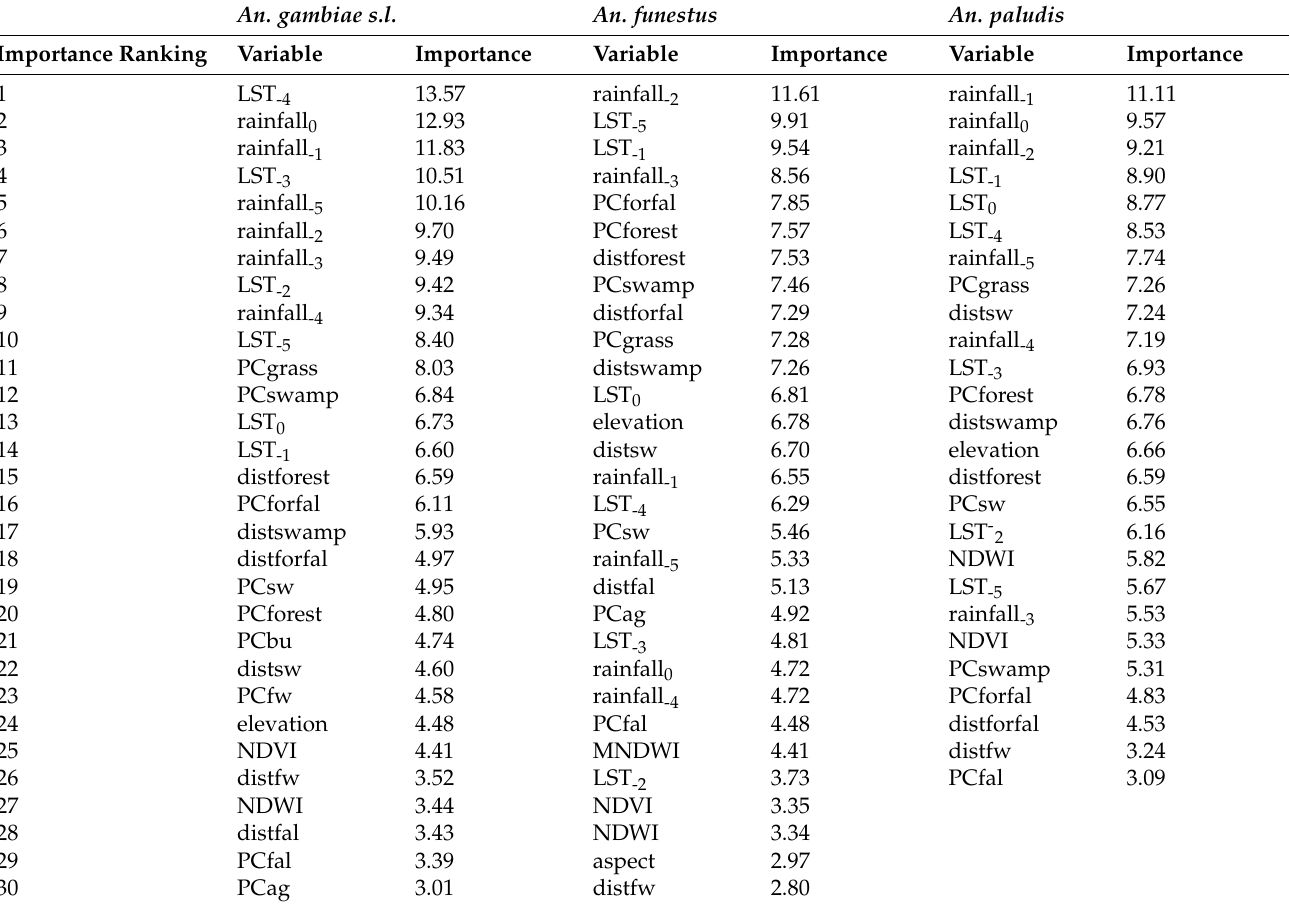
Table 5. Random Forest variable importance rankings of explanatory variables retained after variable stepwise removal for An. gambiae s.l., An. funestus, and An. paludis. Rainfall-x, where -x is the num- ber of months prior (rainfall0 = current month, rainfall-1 = one month prior, etc.), PC = proportional coverage of, dist = distance to, bu = built-up, fal = fallow, forest = forest, forfal = forest and fallow combined, grass = grassland, swamp = swamp, ag = agriculture, fw = flowing water, sw = static water, NDWI = Normalised Difference Water Index, NDVI = Normalised Difference Vegetation Index, SAVI = Soil Adjusted Vegetation Index, MNDWI = Modified Normalised Difference Water Index, LST = Land Surface Temperature, Importance = mean decrease in accuracy of species abundance if variable is removed from the random forest